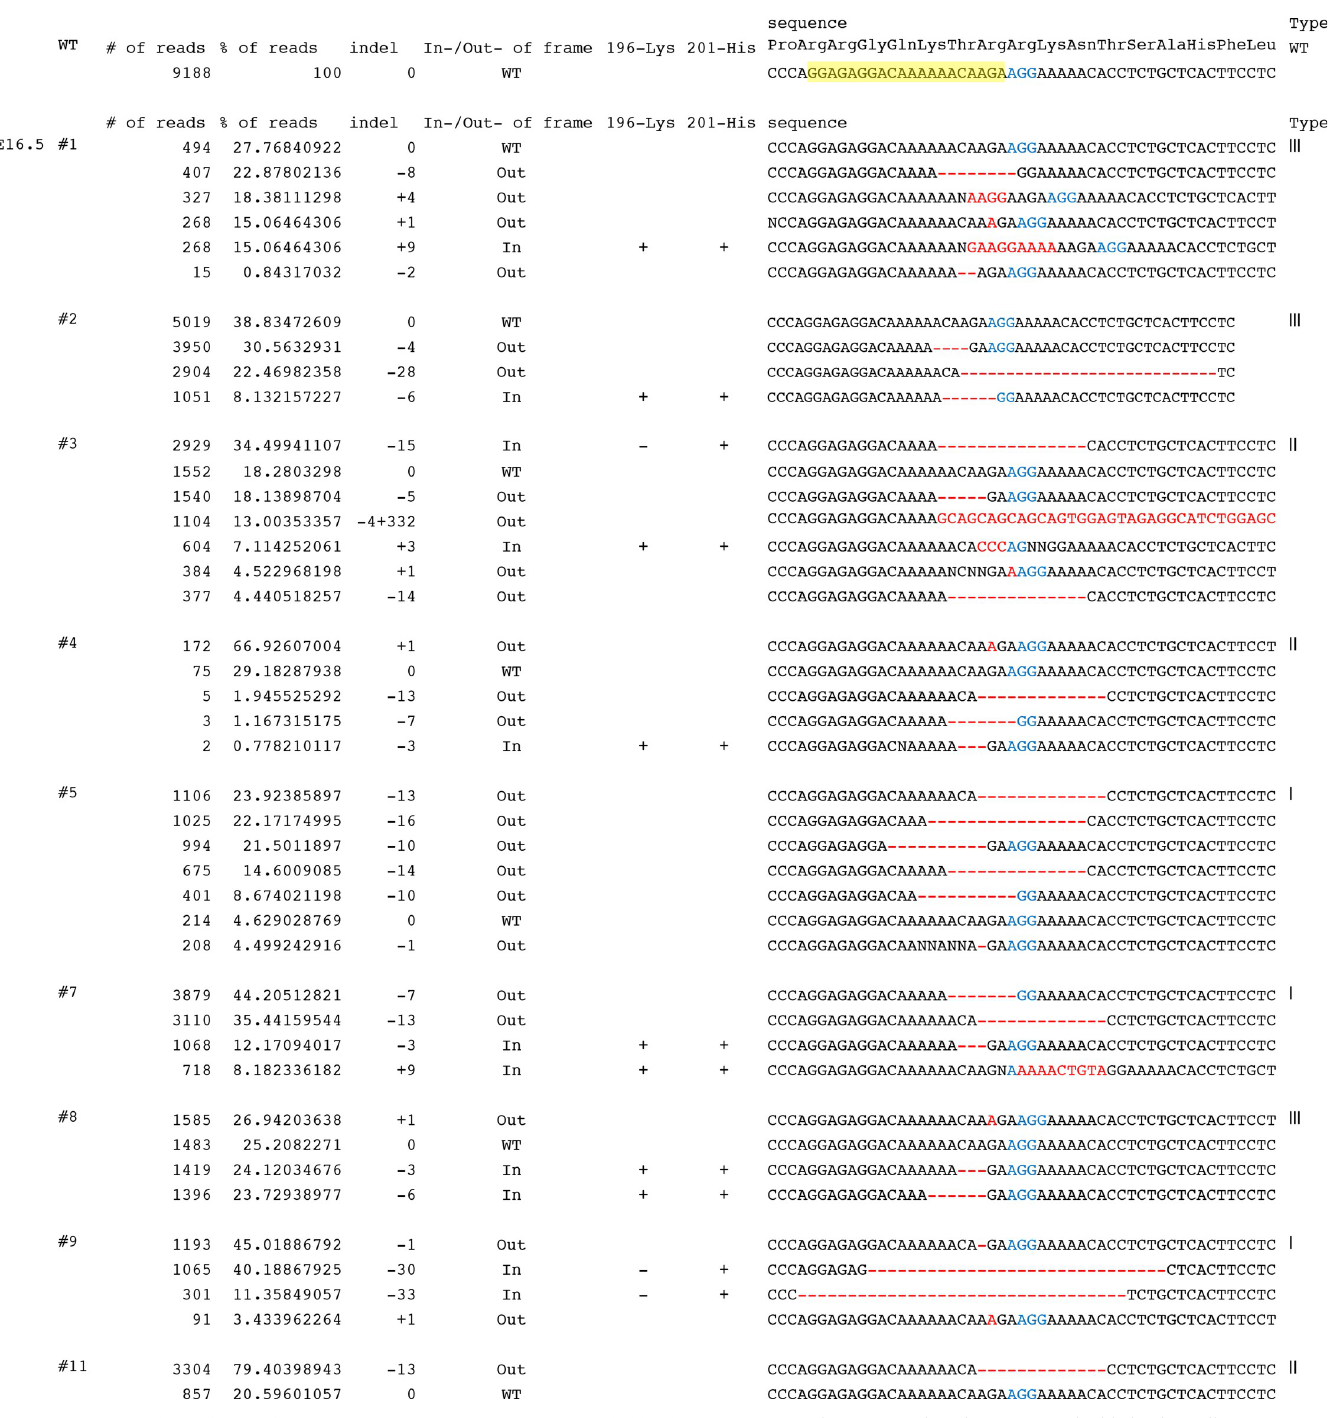
PLOS ONE | https://doi.org/10.1371/journal.pone.0240333 October 15,